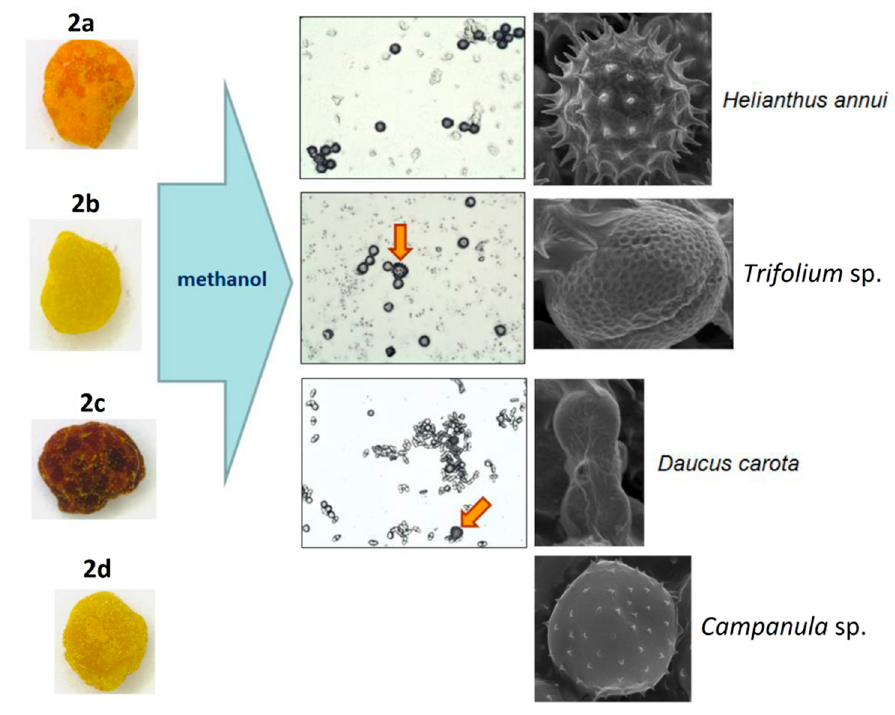
Figure 7. Microscopic identification of pollen grains in methanol extracts from yellow, brown, and orange ( 2a – d ) loads of BP2 .